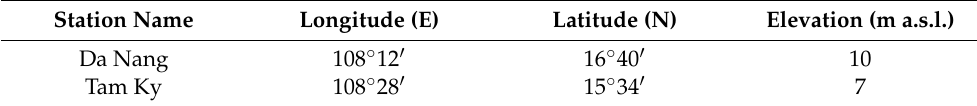
Table 1. Geographical characteristics of the study’s weather station